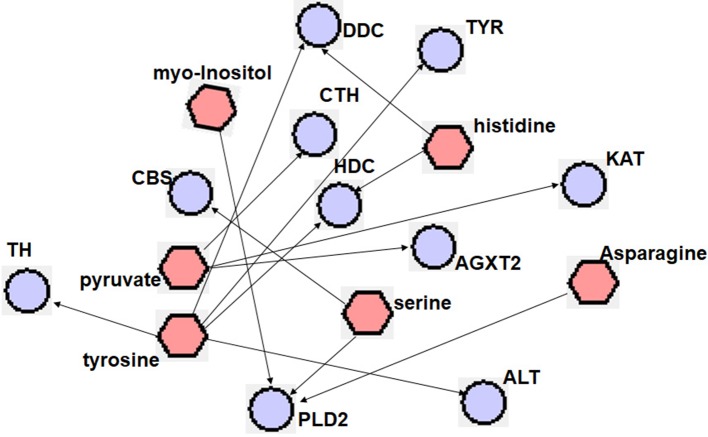
Metabolites associated with hypertension-related proteins. Metabolites and proteins are represented with  and , respectively. TH, tyrosine hydroxylase; CBS, cystathionine-beta-synthase; DDC, dopa decarboxylase; CTH, cystathionase (cystathionine gamma-lyase); TYR, tyrosinase; HDC, histidine decarboxylase; PLD2, b phospholipase D2; AGXT2, alanine-glyoxylate aminotransferase 2; KAT, kynurenine aminotransferase; ALT, gaspartate aminotransferase 2.